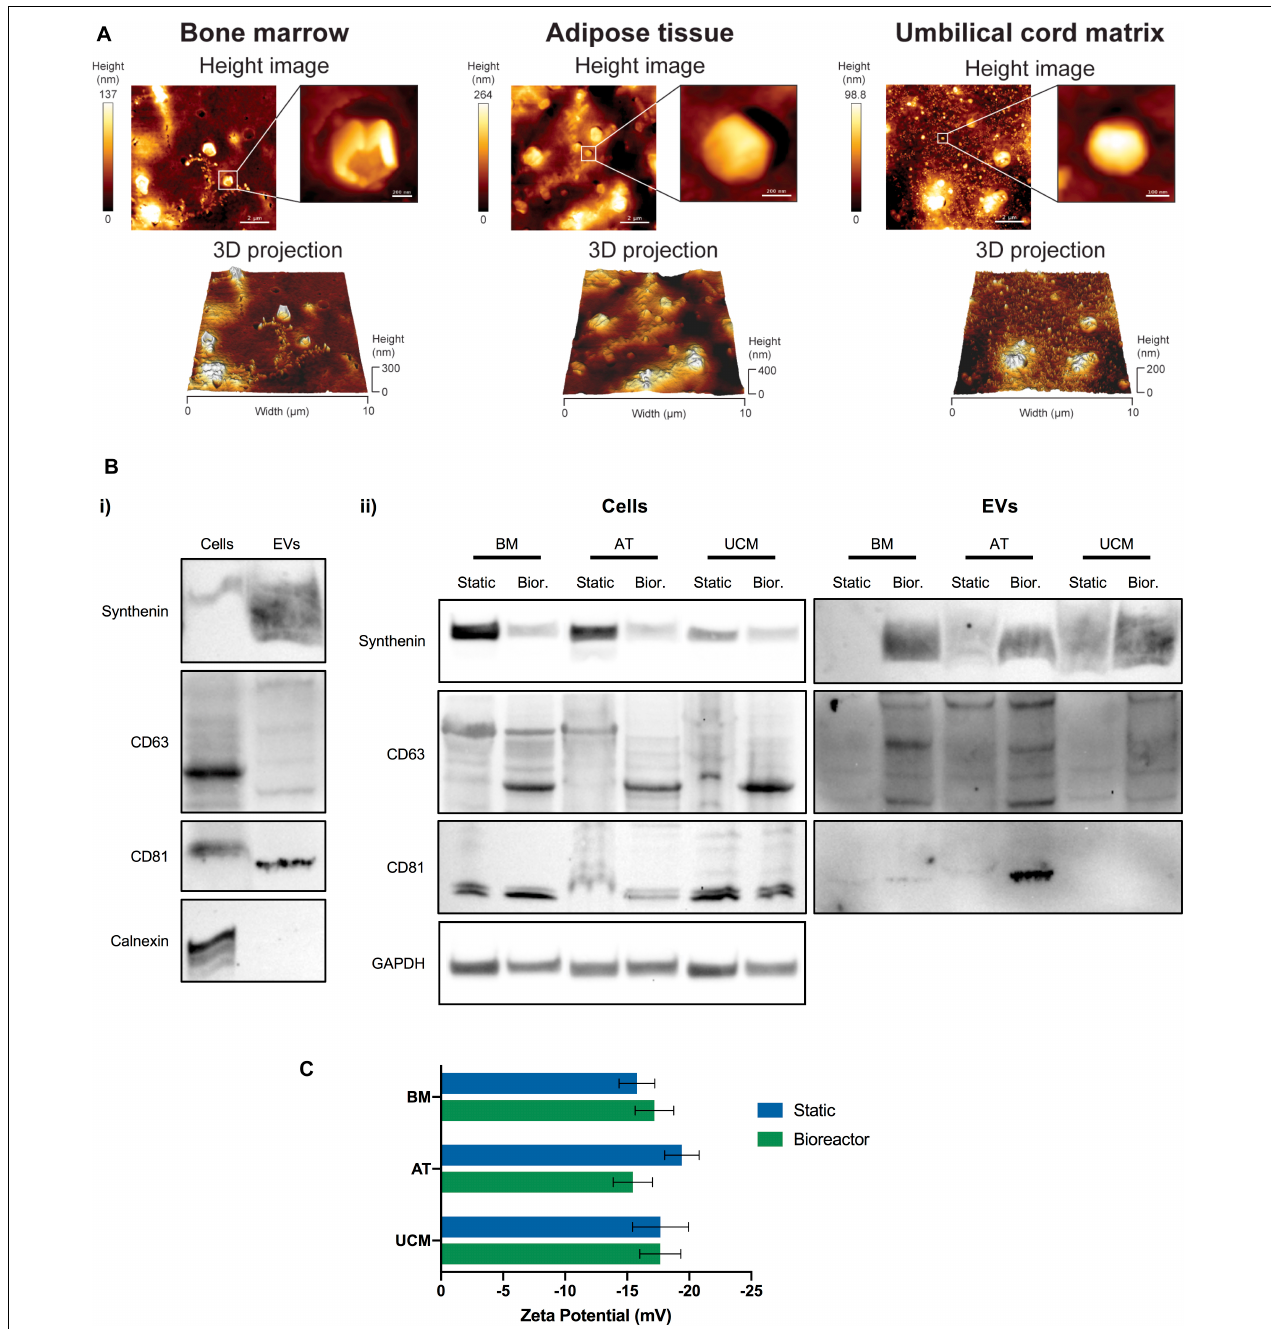
FIGURE 3 | Characterization of MSC-EVs. (A) Representative AFM images of MSC-EVs obtained in the VWBR system, using MSC from three different human tissue sources (bone marrow, adipose tissue, and umbilical cord matrix). AFM height images (top) and respective 3D projections (bottom), capturing a total area of 10 × 10 µ m. A close-up image focusing on a single EV is presented for each AFM height image. (B) Western blots of MSC lysates and MSC-EV samples. ( i) Representative Western blot images of synthenin, CD63, CD81 and calnexin detection in MSC-EVs and corresponding WCL (i.e., cells) obtained from VWBR cultures. (ii) Western blot detection of synthenin, CD63 and CD81 in MSC-EV samples and corresponding WCL (i.e., cells), obtained from BM, AT and UCM MSC after EV production in static and VWBR systems. Detection of the housekeeping protein GAPDH in the same WCL preparations. (C) Zeta potential measurements of the surface charge of MSC-EVs (mV), obtained in either static or VWBR systems, using MSC from three different human sources (BM, AT, and UCM). Results correspond to one representative experiment for each condition. Results are presented as mean ± SD. AFM, atomic force microscopy; WCL, whole cell lysates; BM, bone marrow; AT, adipose tissue; UCM, umbilical cord matrix; VWBR, Vertical-WheelTM bioreactor.